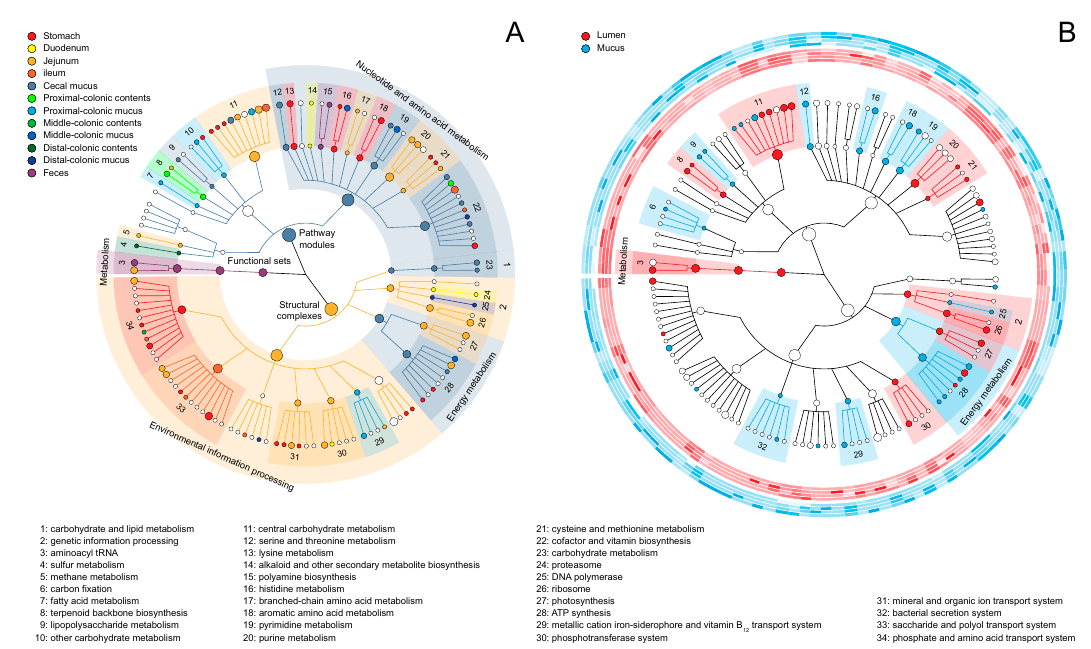
Figure 2. The modular difference in metabolic landscapes across the sampling sites and niche locations: The cladograms illustrate the differentially abundant metabolic modules under the KEGG BRITE hierarchy, determined using the linear discriminant analysis (LDA) effect size (LEfSe) and colored by their most abundant ( A ) sites and ( B ) locations in the rat GIT. The dot size is proportional to the global relative abundance of the corresponding module. In panel ( A ), the whole GI axis was involved in biomarker mining, whereas in panel ( B ), only the adjacent mucosal and luminal compartments from the large intestine were involved. Around the cladogram are located 8 heatmap rings, where the saturation of each cell represents the average relative abundance of each module in different sampling sites (from within outward: caecal contents; proximal-, middle-, distal-colonic contents; caecal mucus; and proximal-, middle- and distal-colonic mucus). All relative abundances are z-score normalized in the radial direction for visualization. The complete lists of modules are presented in Tables S1 and S2.